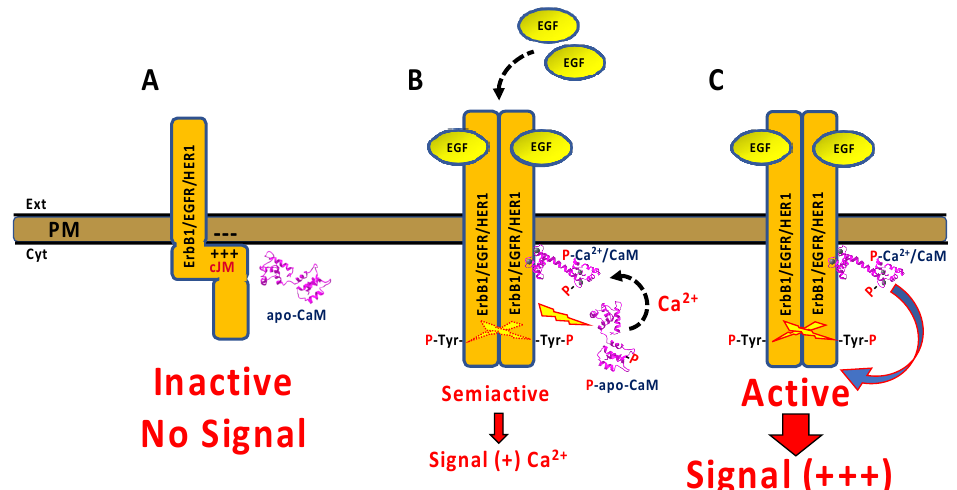
Figure 1. Model of EGFR activation by the cooperative action of EGF and the phospho- Ca 2+ -CaM complex. The cartoon shows ( A ) the ligand-free inactive EGFR, in which the cytosolic juxtamembrane region ( cJM ) is electrostatically bound to the inner leaflet of the plasma membrane ( PM ) inhibiting the receptor [25], and Ca 2 -free CaM ( apo-CaM ) is near to the receptor. ( B ) Binding of the ligand EGF induces EGFR dimerization, a weak activation sufficient to phosphorylate apo-CaM [30,31] and induce a Ca 2+ transient that forms the Ca 2+ /CaM complex, which binds to the CaM-BD at the cJM that is released from the inner leaflet of the PM . ( C ) EGF plus phospho-Ca 2+ /CaM induce the full activation and signaling of the receptor. The structures of Ca 2+ -bound CaM (PDB ID: 1CLL) [32] and apo-CaM (PDB ID: 1DMO) [33] were taken from the National Center for Biotechnology Information (NCBI). Apo-CaM, Ca 2+ -free calmodulin; Ca 2+ /CaM, Ca 2+ -bound CaM; CaM-BD, CaM-binding domain; cJM, cytosolic juxtamembrane region; Cyt, cytosol; EGF, epidermal growth factor; EGFR, EGF receptor; Ext, extracellular medium; PM, plasma membrane.